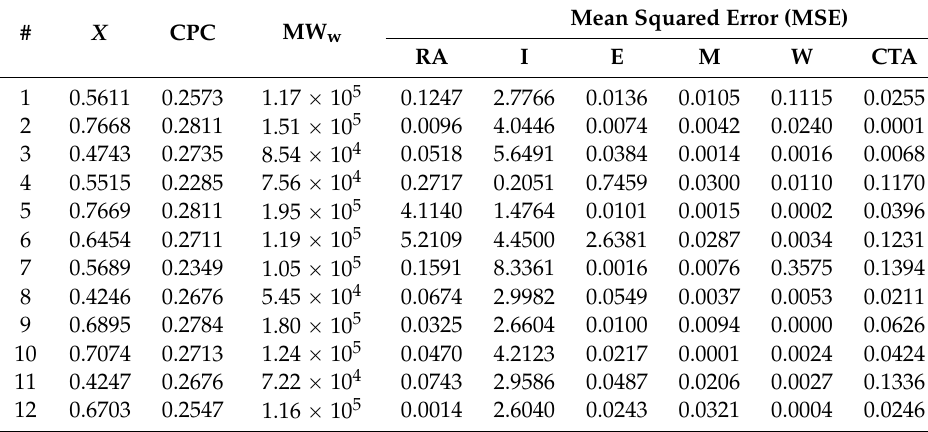
Table 3. MSE values for the 12 untested datasets using ANN.